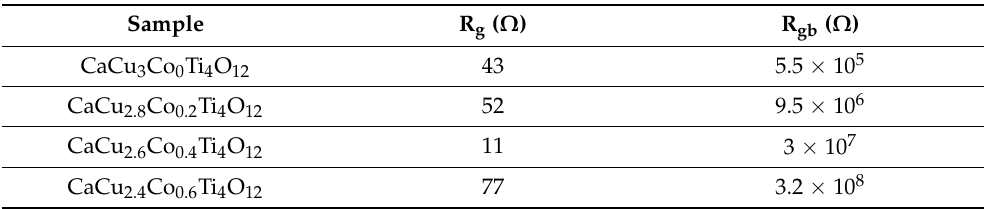
Table 2. The resistance of grains and grain boundaries of CaCu(3 − x)CoxTi4O12 Ceramics (x = 0, 0.2, 0.4 and 0.6)